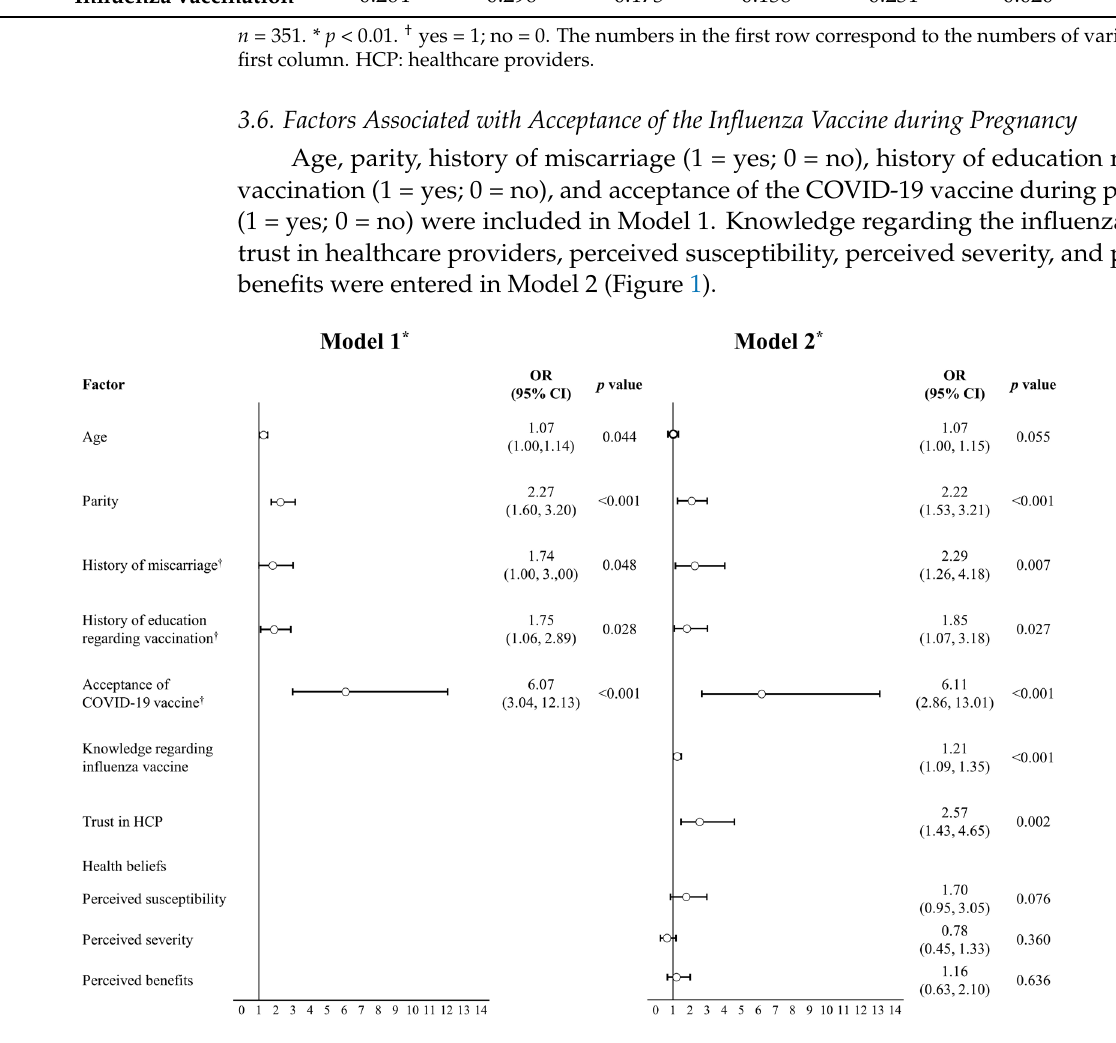
Figure 1. Factors associated with the acceptance of the influenza vaccine during pregnancy. n =